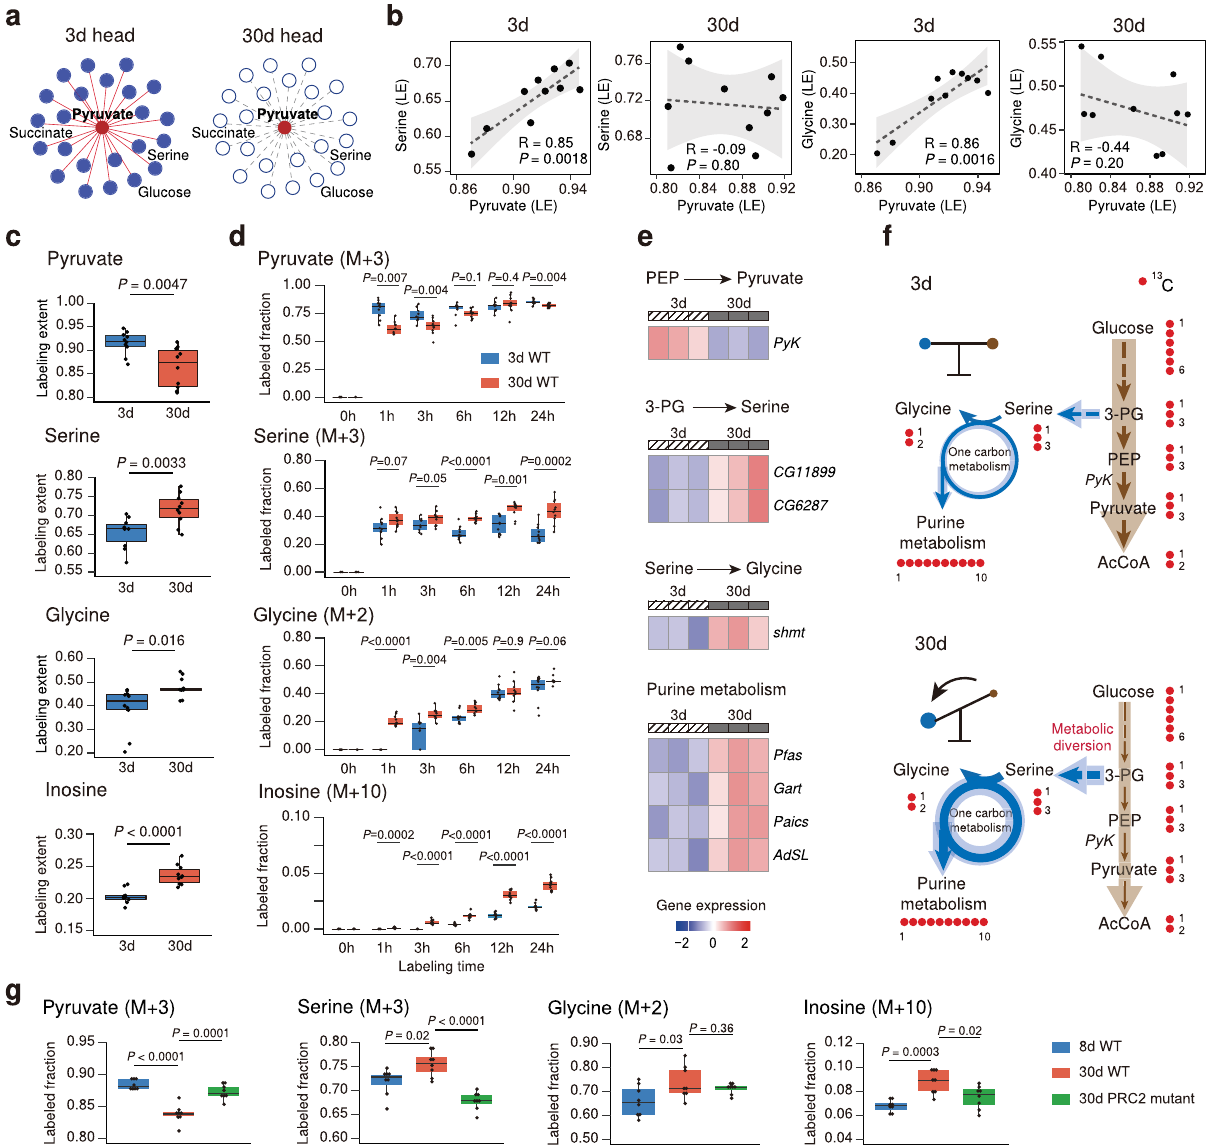
Fig. 5 Metabolic shift from glycolysis to serine metabolism in aging Drosophila . a Correlation network showing the correlation between labeled pyruvate and other labeled metabolites in Drosophila head tissue. Red line, signi fi cant correlation; gray dashed line, no correlation. b Correlations between labeled pyruvate and serine or glycine during aging ( n = 10 biological replicates in each group). Dashed line, linear regression; gray shadow, 95% con fi dence interval of the linear relationship between pyruvate and serine or glycine. The p -value of Pearson correlation coef fi cient was calculated by two-sided Student ’ s t -test. c Labeling extents (LE) of metabolites in 3d and 30d Drosophila ( n = 10 biological replicates per group; two-tailed Student ’ s t -test). d Boxplots showing the labeled fractions of pyruvate ( M + 3), serine ( M + 3), glycine ( M + 2) and Inosine ( M + 10) at each time point in 3d and 30d WT fl ies ( n = 10 biological replicates in each group). e Heat maps of the z -score normalized gene expression levels of enzymes. The signi fi cantly changed genes were shown ( P -value < 0.05; two-tailed Student ’ s t -test). f The proposed model of metabolic rewiring in aging Drosophila . g Boxplots showing the labeled fractions of pyruvate ( M + 3), serine ( M + 3), glycine ( M + 2), and Inosine ( M + 10) in 8d WT, 30d WT, and 30d Drosophila with PRC2 mutation ( n = 8 biological replicates in each group). In d , g , the labeled fraction was normalized to the fraction of glucose ( M + 6). In c , d , g , the centerlines of the boxplots indicate the median values; the lower, and upper lines in boxplots correspond to 25th and 75th quartiles, and the whiskers indicate the largest and lowest points inside the range de fi ned by 1st and 3rd quartile plus 1.5 times interquartile ranges (IQR). Two-tailed Student ’ s t -test. Source data are provided as a Source Data fi